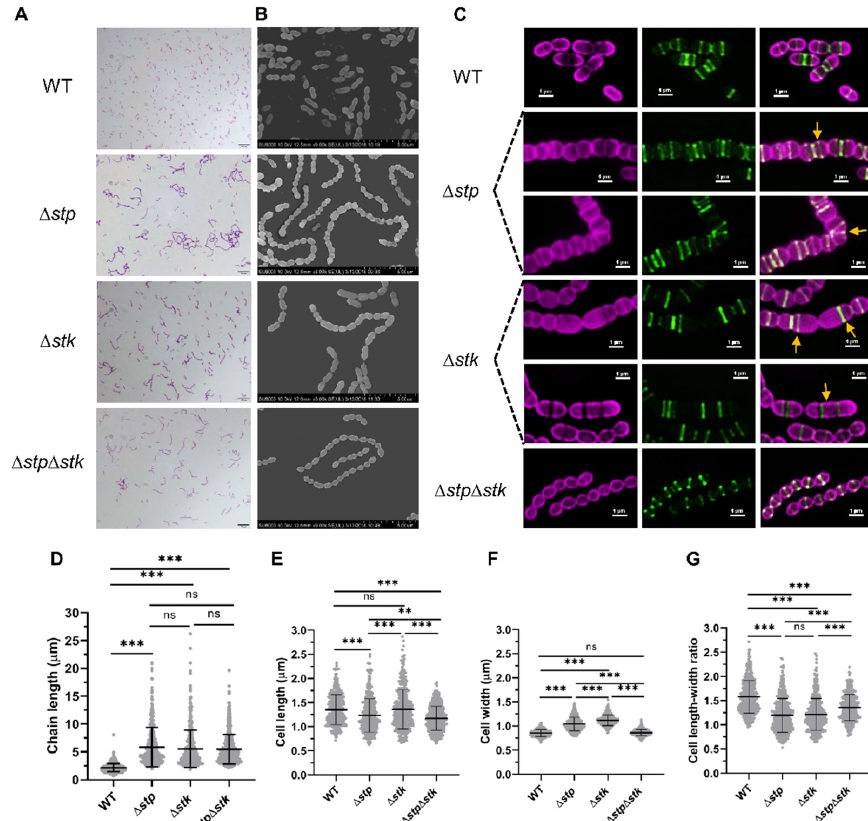
Figure 4. Morphological analysis of the Δ stp , Δ stk , and Δ stp Δ stk strains. ( A ) Gram staining images of the mid-log phase cells of WT, ∆ stp , ∆ stk, and ∆ stp ∆ stk strains. The scale bars are 10 µ m. ( B ) Scanning electron microscope analysis of the WT, ∆ stp , ∆ stk, and ∆ stp ∆ stk strains. The scale bars are 5 µ m. ( C ) Structured illumination microscopy (SIM) analysis of WT, ∆ stp , ∆ stk, and ∆ stp ∆ stk strains. The mid-log phase cells were stained with AF-647 and FDL dyes, followed by imaging with SIM. The scale bars are 1 µ m. ( D ) Chain length of WT, ∆ stp , ∆ stk , ∆ stp ∆ stk strains. The results were obtained by measuring at least 400 chains per sample. ( E – G ) Cell size parameters of WT, ∆ stp , ∆ stk , and ∆ stp ∆ stk strains. n WT = 370, n ∆ stp = 381, n ∆ stk = 385, n ∆ stp ∆ stk = 447. Data are presented as the mean ± standard deviations. Statistical significance was determined by two-tailed, unpaired Student’s t -tests (ns, p value > 0.05; **, p value < 0.01; ***, p value <